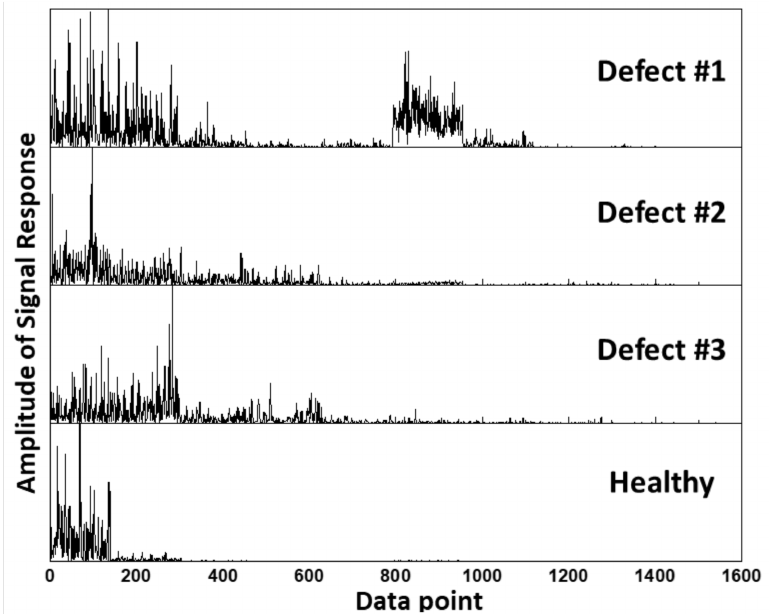
Figure 6. Plot of the reconstructed data sets for the drill bits with different health conditions.